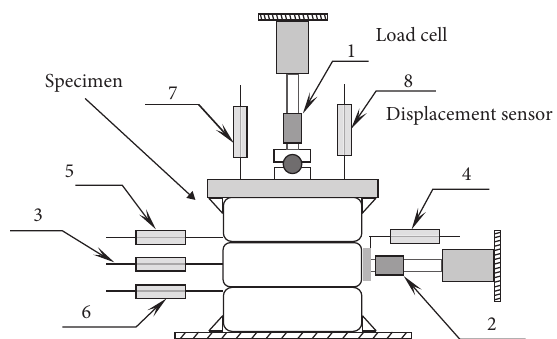
Figure 11: The arrangement of load cell and displacement sensor: (1) BLR-1/600, as L 1 ; (2) BLR-1/400, as L 2 ; (3) YWD-200, as Disp1; (4) YWD-200, as Disp2; (5) YWD-100, as Disp3; (6) YWD-100, as Disp4; (7) YWD-100, as Disp5; (8) YWD-100, as